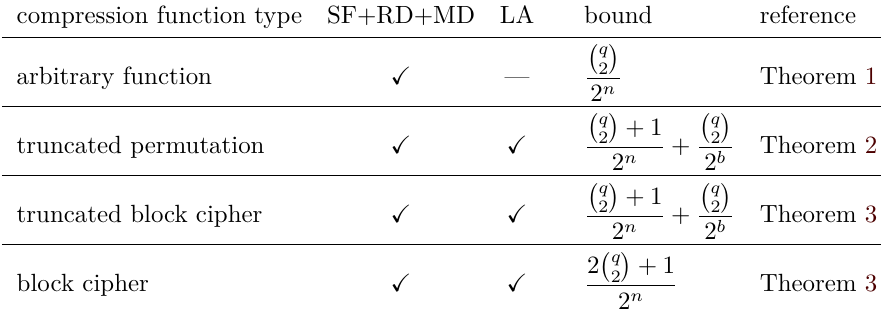
Table 1: Indifferentiability bounds for hashing modes of an arbitrary function, a truncated permutation or a (truncated) block cipher. The conditions SF, RD, MD, and LA stand for subtree-freeness, radical-decodability, message-decodability, and leaf-anchoring, respectively. q is the adversarial complexity expressed as the number of primitive queries either direct or indirect, n the CV length, and b ≥ n the width of the permutation resp. the block length of the block